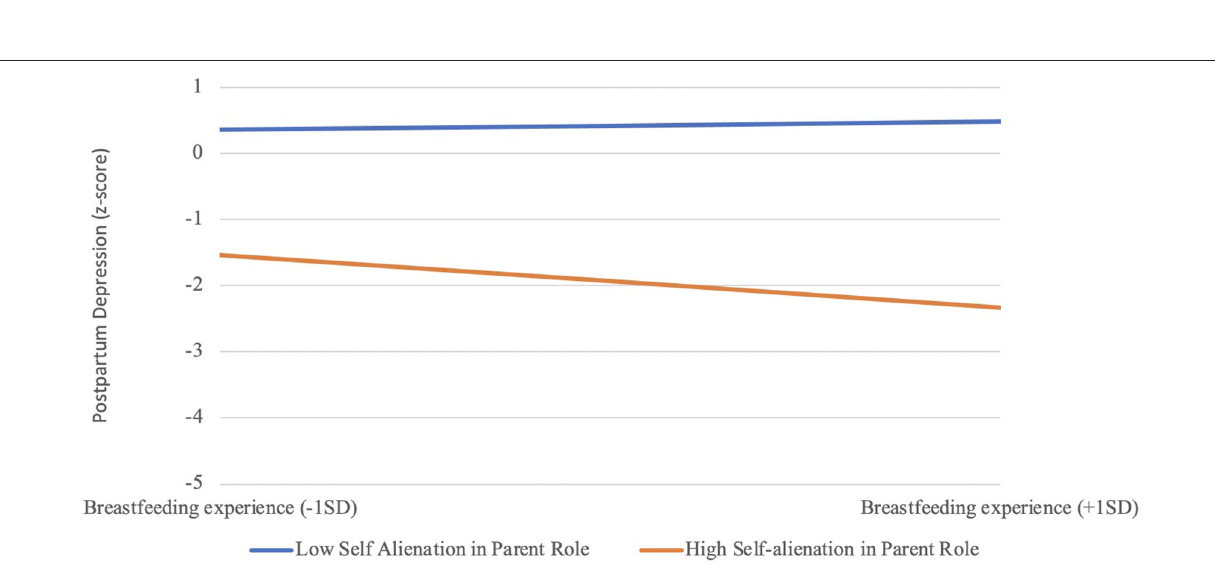
FIGURE 2 | Self-alienation in the parent parent role moderates link between breastfeeding experience and symptoms of postpartum